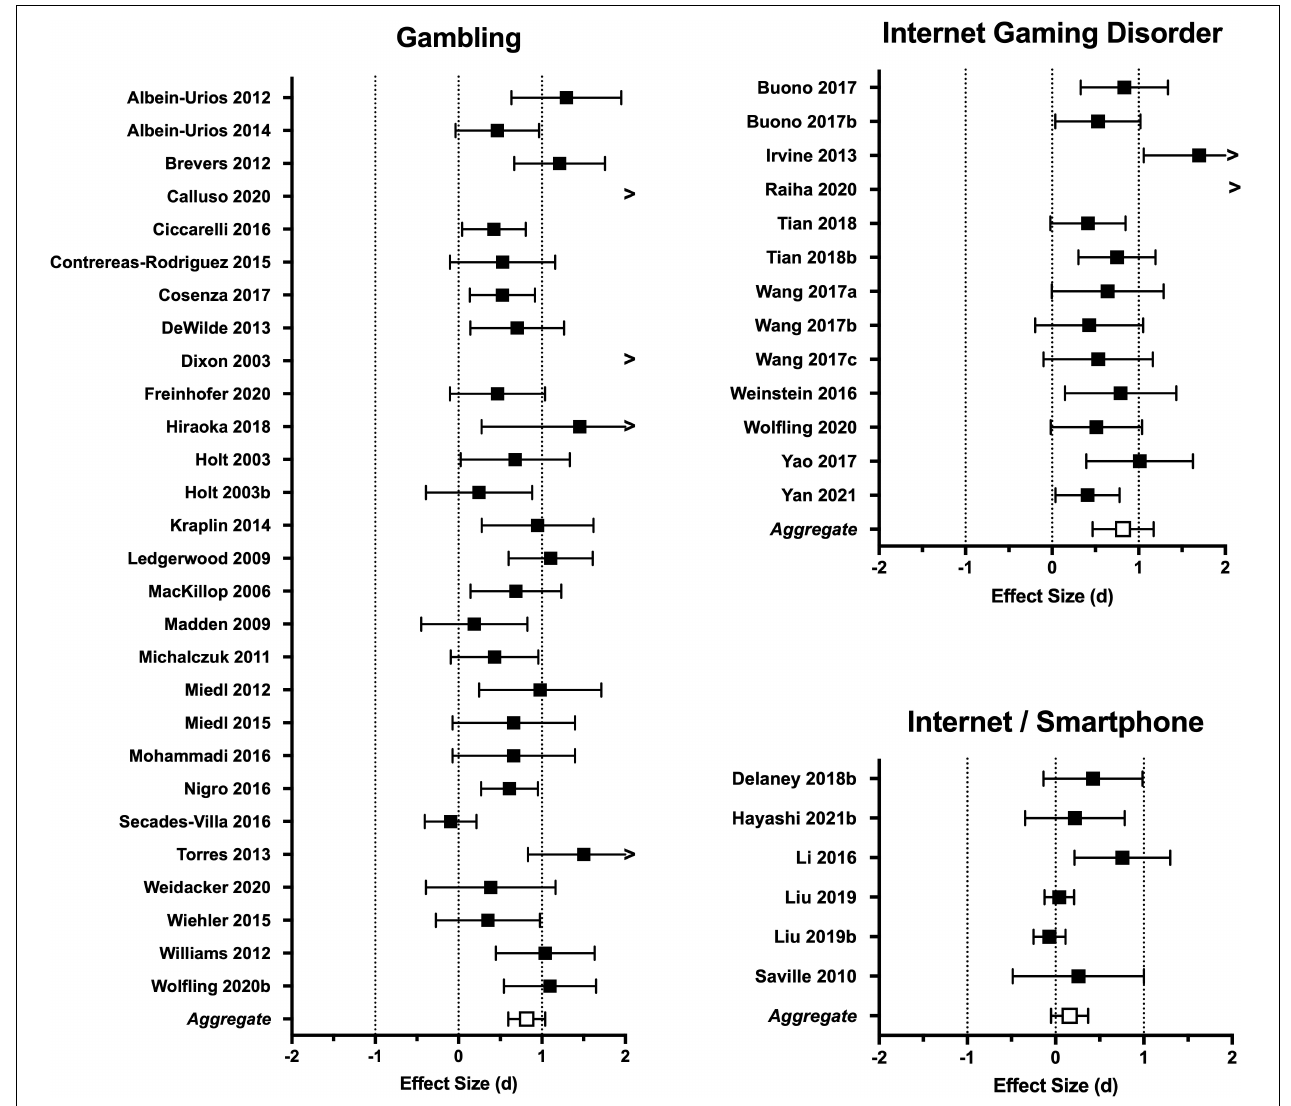
FIGURE 2 | Forest plots depicting effect sizes for categorical studies. Individual data points reflect effect size (Cohen’s d) and 95% confidence intervals. The aggregate effect size generated by the random-effects model is provided at the bottom of each forest plot. Complete data is provided in Supplementary Table 3